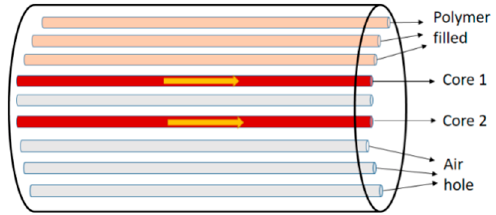
Figure 8. Schematic diagram of the half-filled twin core PCF after the selective polymer filling. It was used for temperature sensing (Figure curtsy from [44] article).